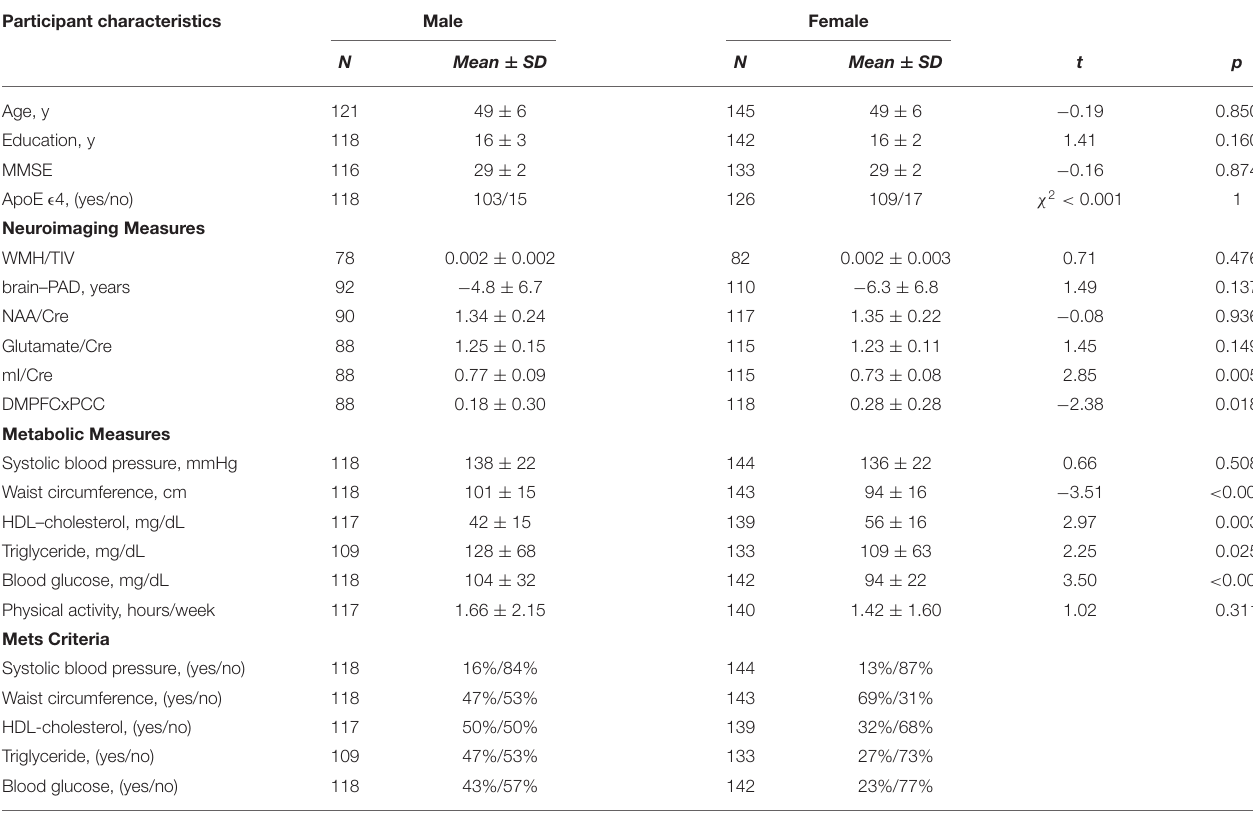
TABLE 1 | Selected participant characteristics ( n =